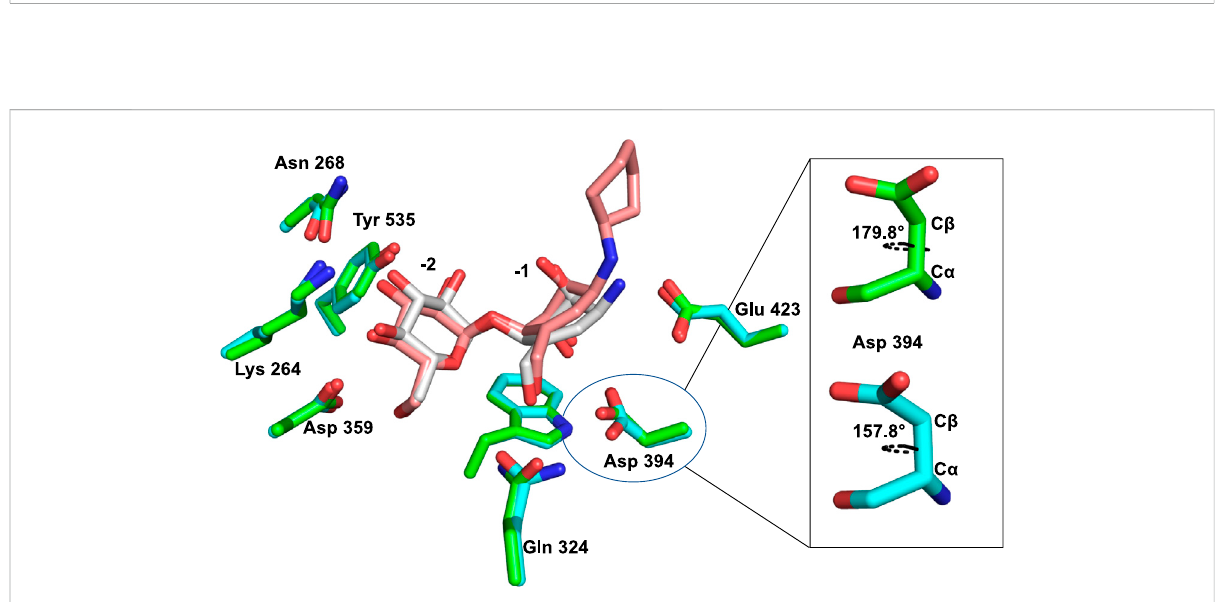
FIGURE 7 Superimposed active sites of Sco GlgEI-V279S/ 13 (pink carbon atoms) and Sco GlgEI-V279S/ AGV (gray carbon atoms) structures.